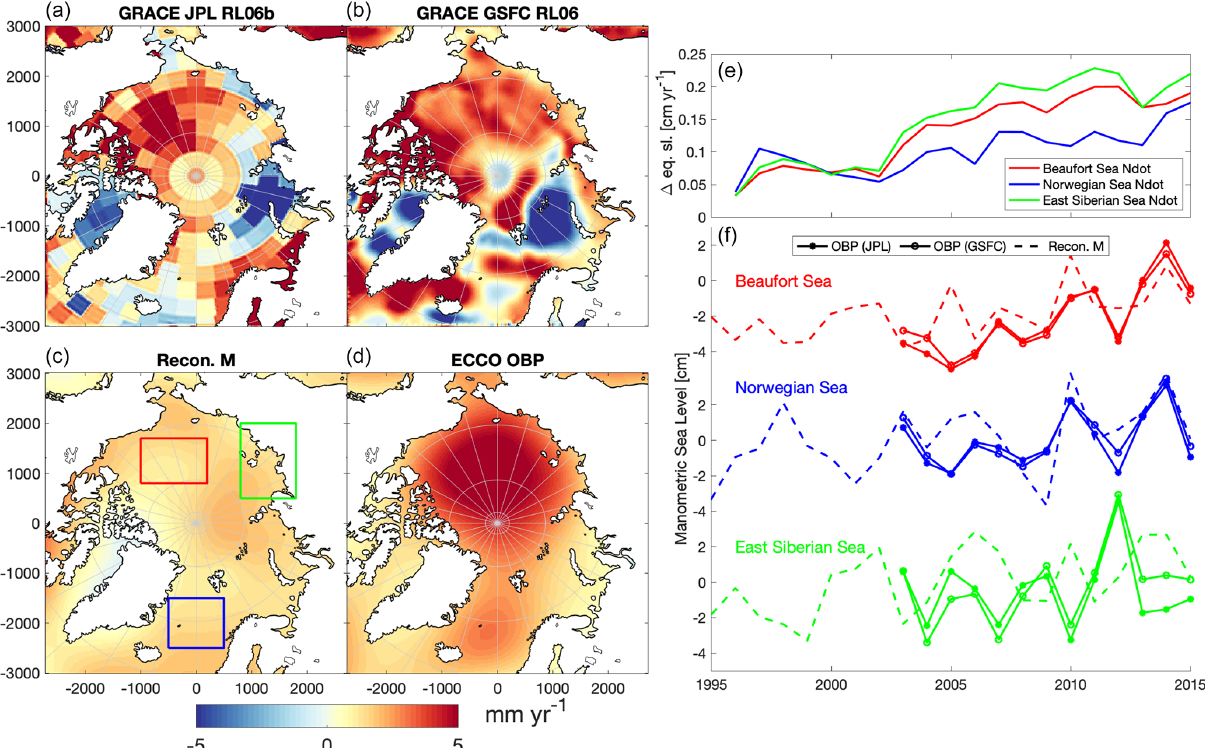
Figure 6. (a–d) Manometric (M) sea level and ocean bottom pressure (OBP) trend estimates [mmyr − 1 ] from 2003–2015 from two GRACE mascon products (a,b) , reconstructed from the contributions in Fig. 5 (c) and from the ECCO model (d) . The year-to-year variation of N (change in geoid + global sea level contribution, Eq. 4) from all sources (land ice + GIA) (in sea level equivalent; cmyr − 1 ) (e) . The yearly variation of GRACE OBP estimates and reconstructed manometric sea level in the Beaufort Sea region (red), Norwegian Sea (blue) and East Siberian Sea (green) as indicated by the squares in the map of the reconstructed manometric sea level [cm] (f)